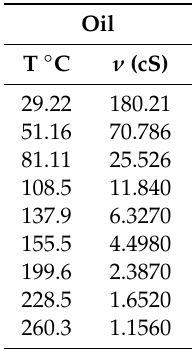
Table 1. Values for temperature-dependent kinematic